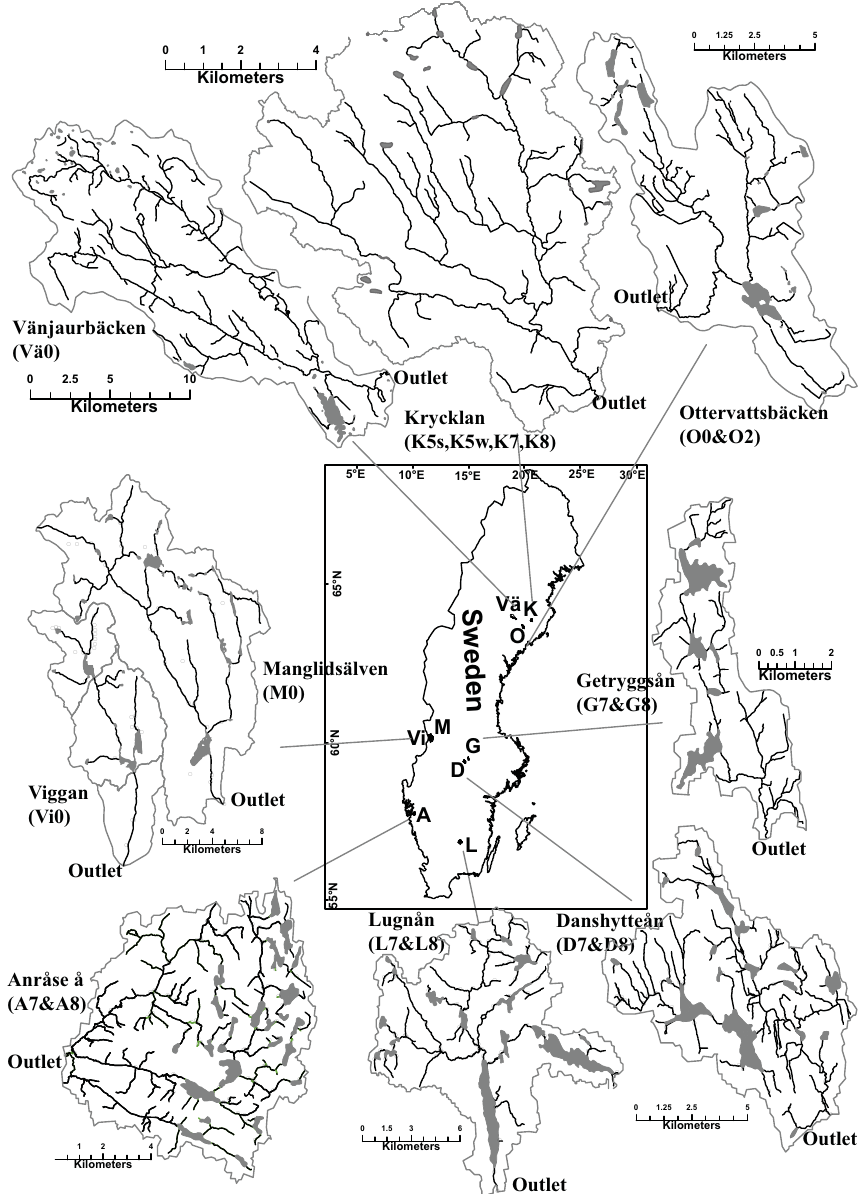
Figure 1. Map of Sweden with the nine investigated catchments, see Table 1 for coordinates. Labels in brackets are the abbreviated names of the catchments and year of